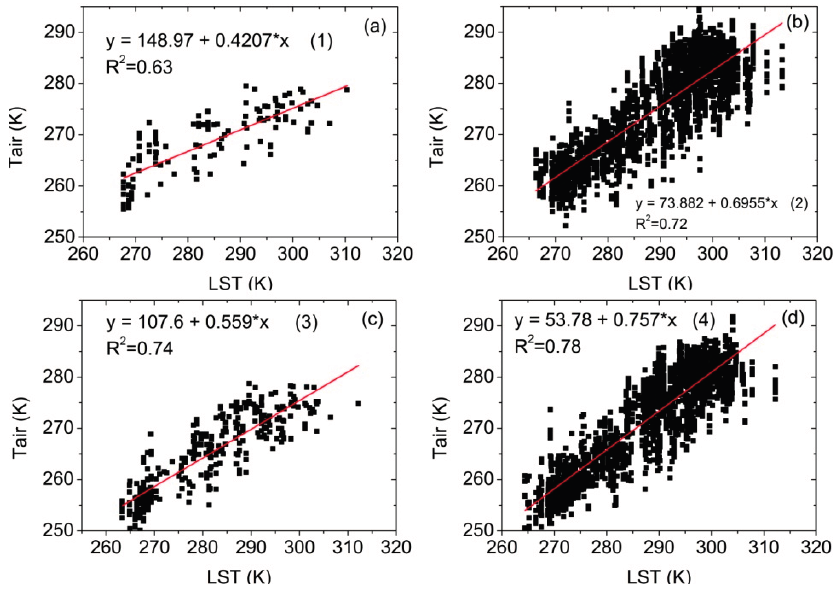
Figure 2. Relationships (Equations (1)–(4)) between T air and LST for Qilian station for ( a ) snow and ( b ) no-snow observations and Yeniugou station for ( c ) snow and ( d ) no-snow observations from hydrological years 2002 to 2007, with linear regression lines and R 2 values also